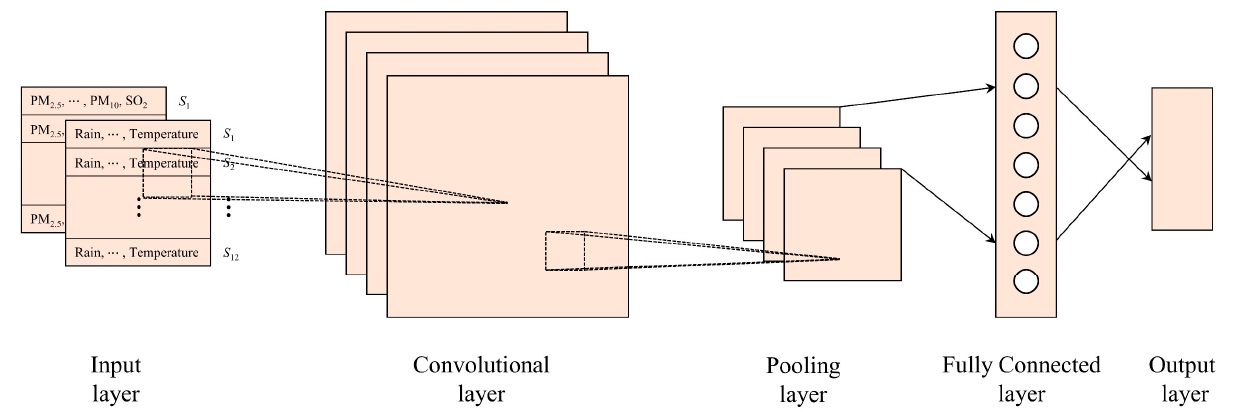
Figure 4. The fundamental architecture of CNN.